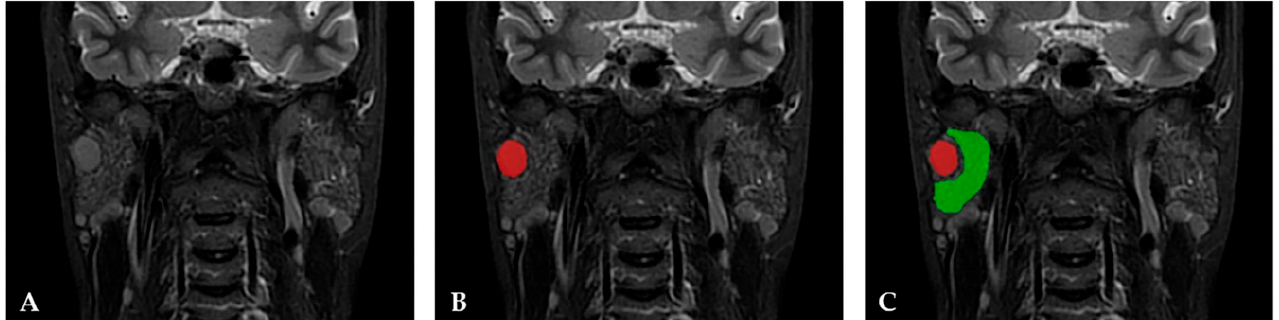
Figure 2. ( A ) MRI coronal STIR PROPELLER sequence of a 45-year-old female patient diagnosed with primary Sjögren’s syndrome and non-Hodgkin lymphoma, MALT subtype in the right parotid gland. ( B ) The software automatically traced the region of interest (ROI) covering the focal lesion corresponding to lymphoma using geometric and gradient coordinates (red area). ( C ) A second ROI was manually delineated (green area), covering the parotid gland’s parenchyma surrounding the focal lesion (this 2D segmentation was used for the textural analysis). Table 1. The extracted radiomics features and the computation settings of each